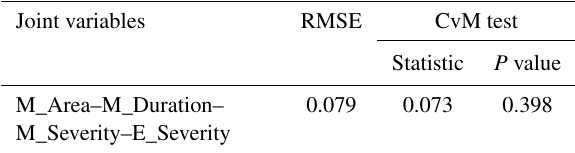
Table 7. Goodness of fit of the multivariate